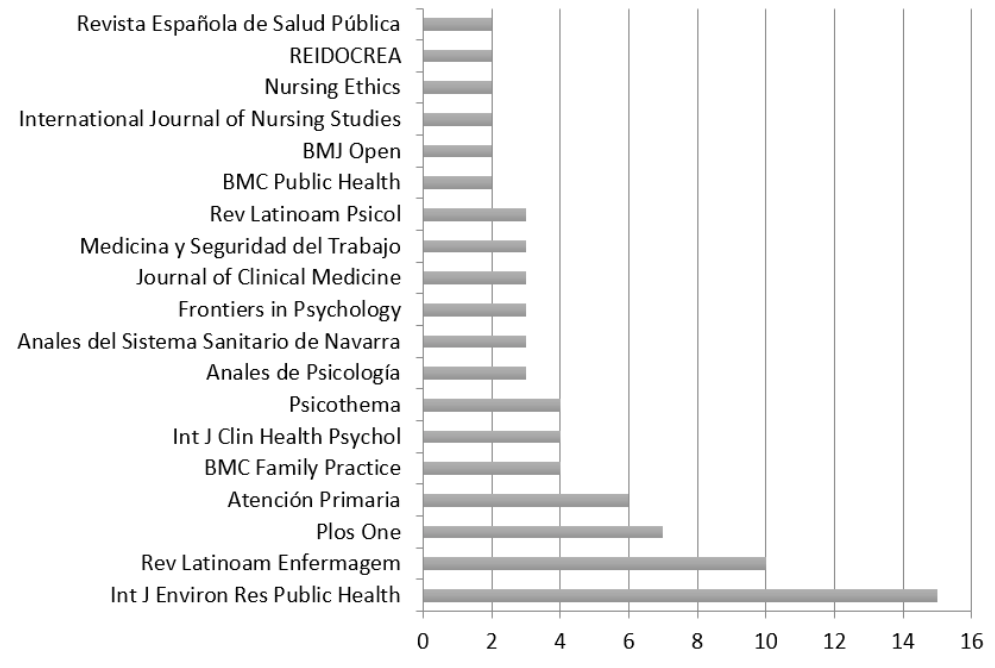
Figure 2. Journals that published the most Spanish studies of burnout in nursing.